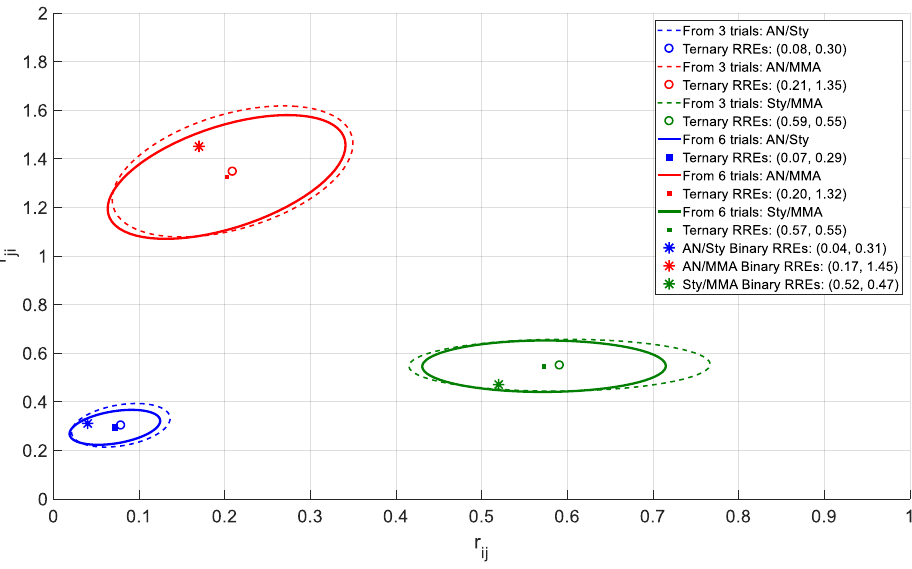
Figure 11. ‘Ternary’ reactivity ratio estimates (RREs) for the terpolymerization of AN / Sty / MMA with the data from Brar and Hekmatyar [35]. Table 8. Analysis of ( a ) composition and ( b ) microstructure for AN / Sty / MMA (experimental data from [35]). RRE = reactivity ratio